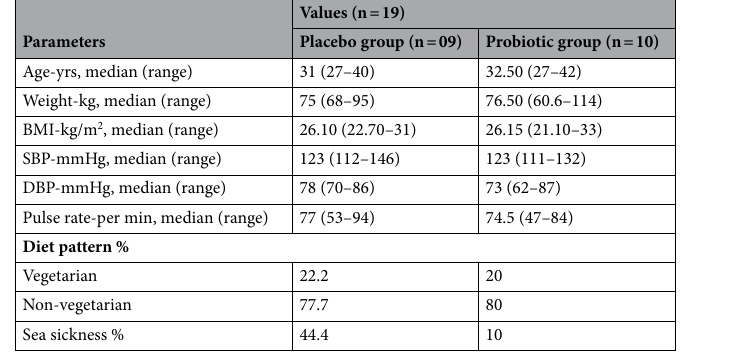
Table 1. Demographic data for 19 study